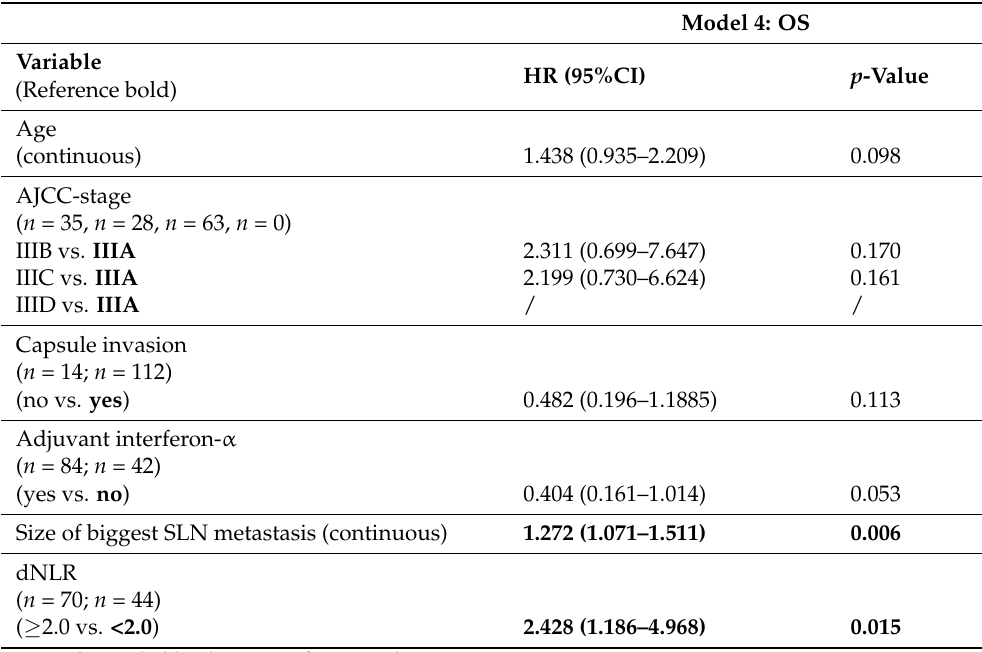
Table 3. Multivariate Cox regression analysis for overall survival with derived NLR